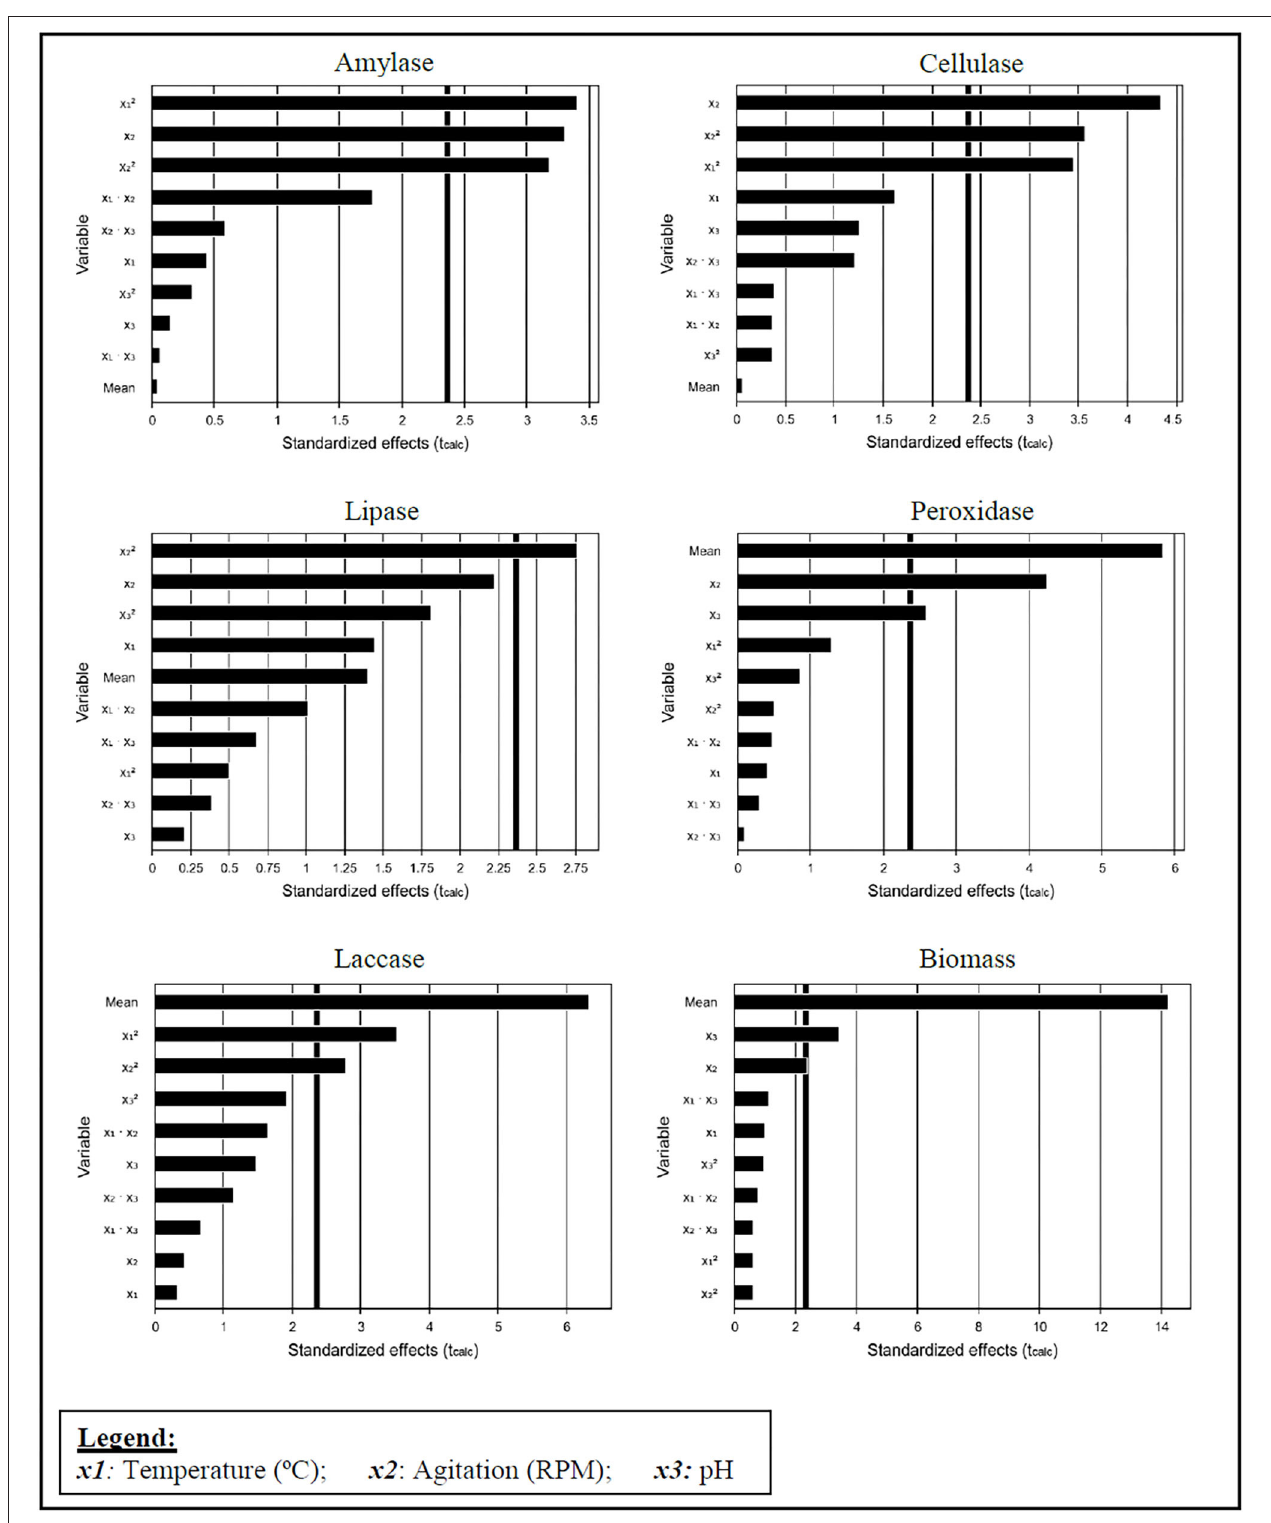
FIGURE 2 | Pareto graph showing the influence of three variables in enzyme activity determination and biomass production.